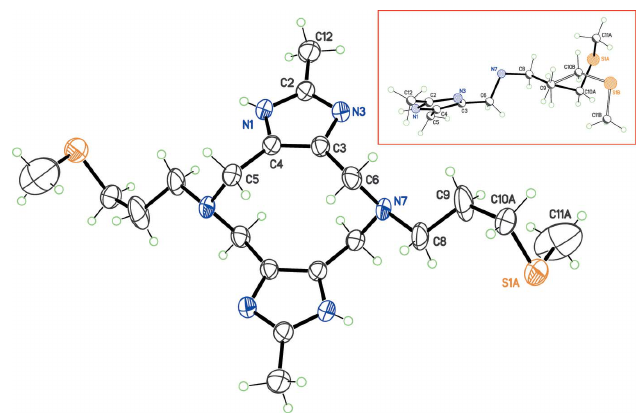
Figure 1 Molecular structure of the title compound, with 50% displacement ellipsoids for non-H atoms. Disordered sites B were omitted for clarity. The complete asymmetric unit is represented in the inset, including A and B disordered sites.